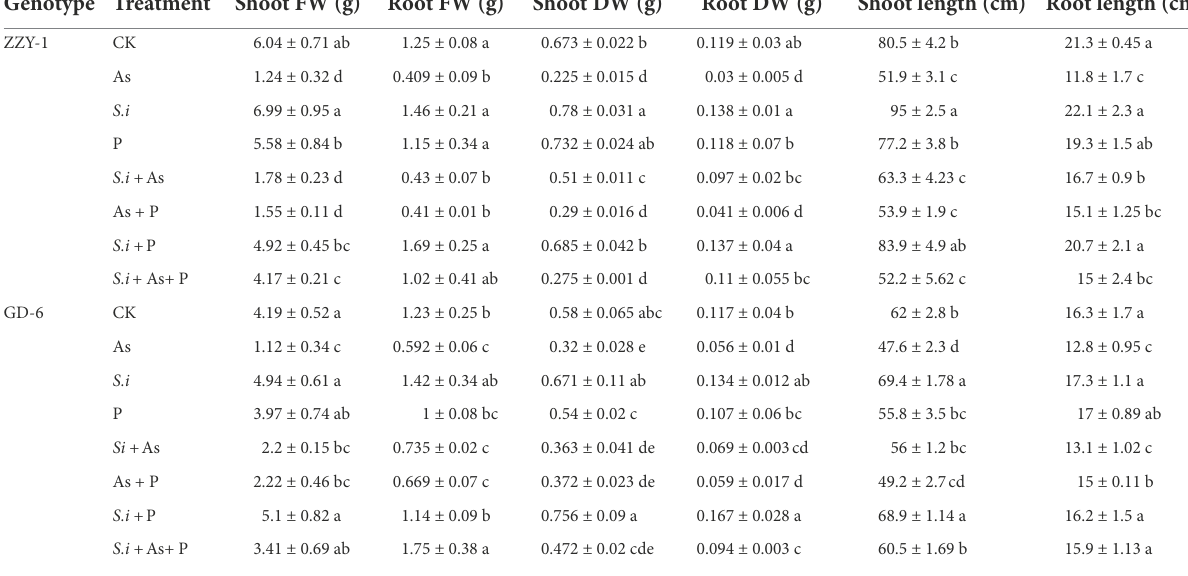
TABLE 2 Growth indices of rice plants differing in arsenic accruing tendency following alone and combined interactions of Serendipita indica symbiosis and phosphorus against arsenic stress. Genotype Treatment Shoot FW (g)